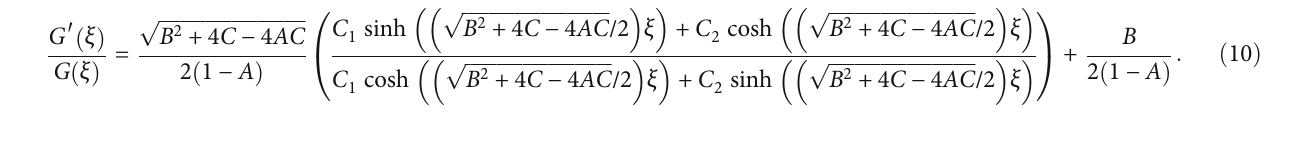
ffiffiffiffiffiffiffiffiffiffiffiffiffiffiffiffiffiffiffiffiffiffiffiffiffiffiffiffiffi p 4 AC − 4 C − B 2